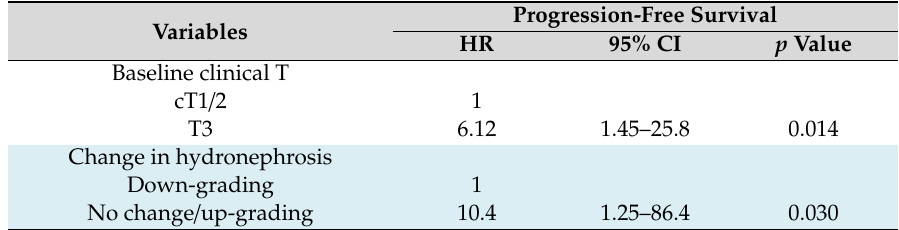
Table 5. Multivariate analysis of baseline and post-NAC variables for progression-free survival in patients with ureteral